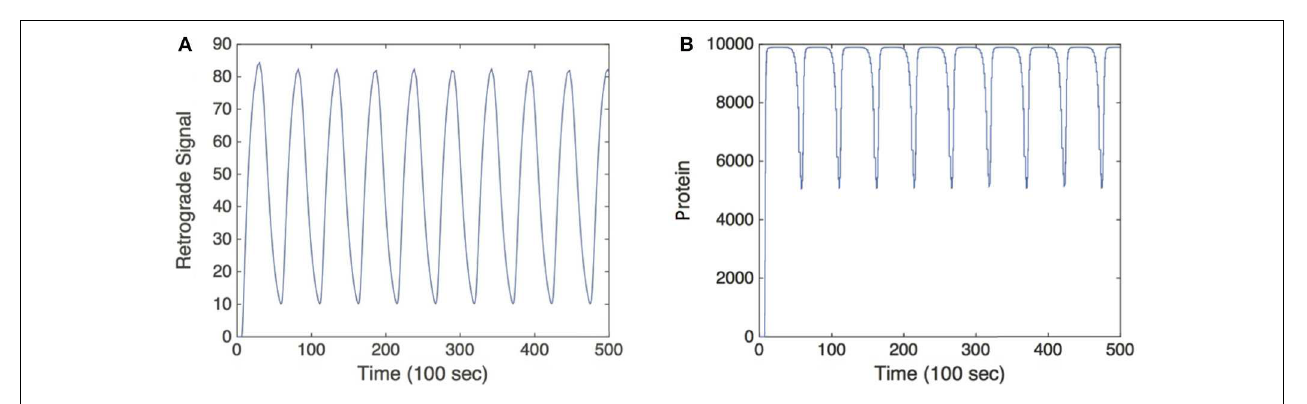
FIGURE 3 | Simulation of the feed forward serial network Equation (5) in response to a retrograde signal from Equation (2). (A) Retrograde signal being fed into gene network, τ 5 . (B) Convergence of the solutions =